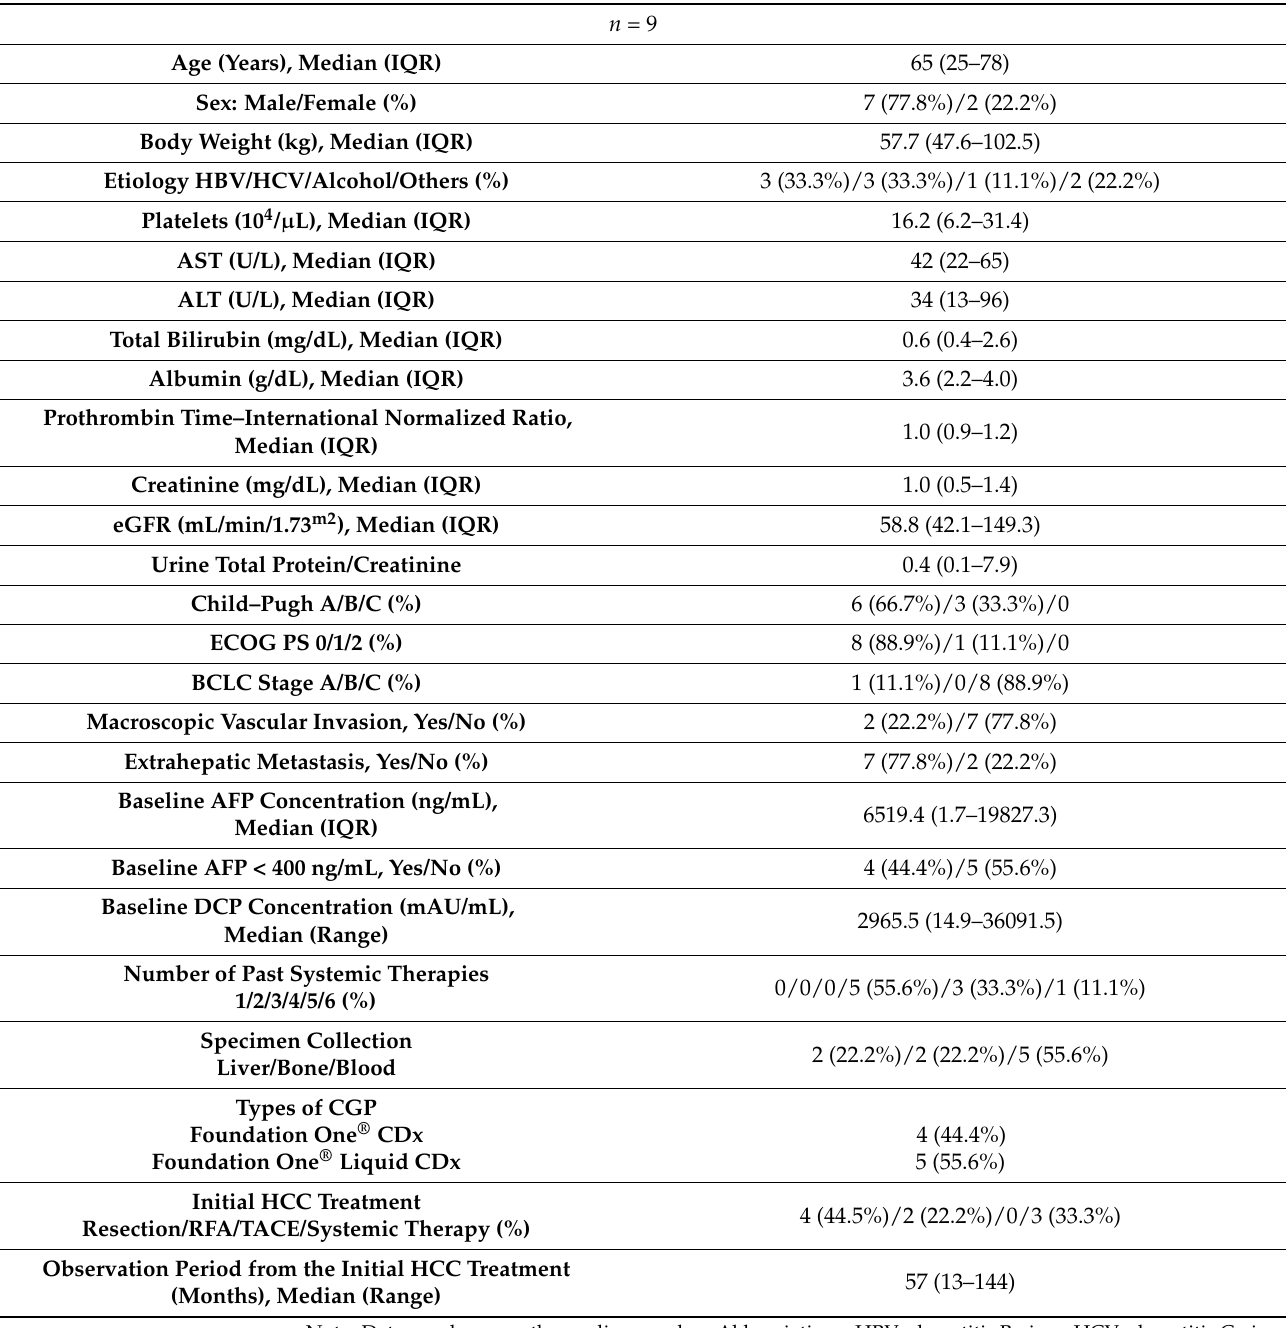
Table 1. Baseline characteristics of the patients at comprehensive genomic profiling